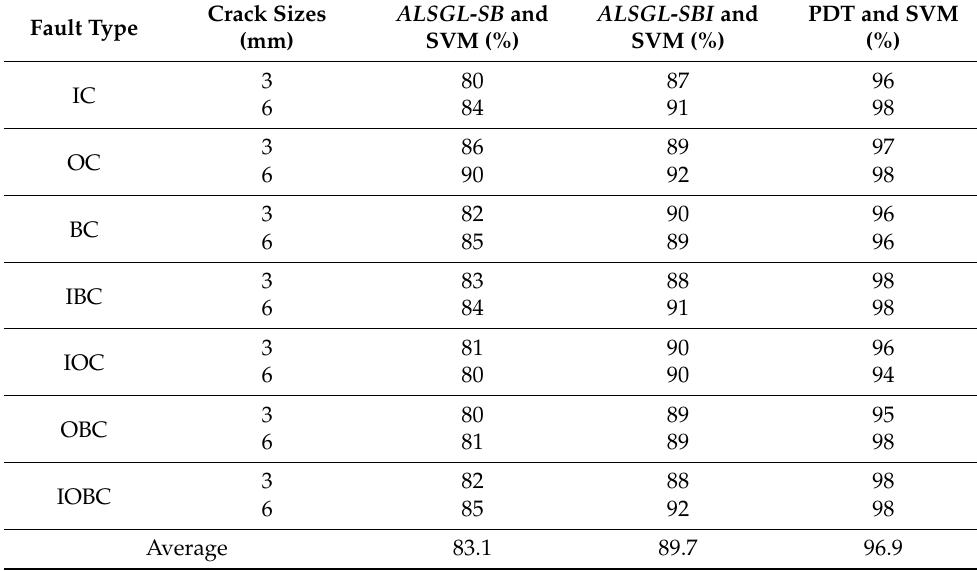
Table 5. Average accuracies for crack size diagnosis using the combined ALSGL - SB and SVM, ALSGL - SBI and SVM, and PDT and SVM